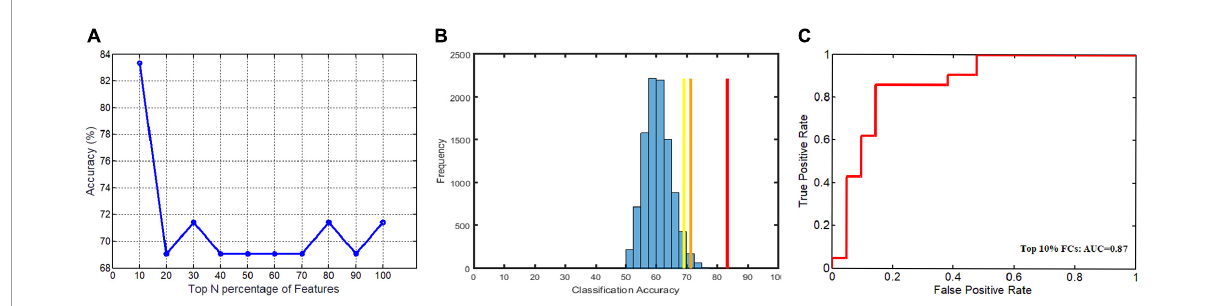
FIGURE1 The classification accuracies of 10 feature selection percentages, the corresponding null distribution, and the receiver operating characteristic (ROC) curve for the highest classification accuracies. (A) The highest classification accuracy (83.33%) was obtained when the top 10% FCs were selected and two lower accuracies (71.43% and 69.05%) were obtained when different numbers of FCs were selected; (B) the corresponding null distribution of the highest chance-level accuracies (the blue histogram), along with the three true classification accuracies (red: 83.33%; orange: 71.43%; yellow: 69.05%); (C) the receiver operating characteristic (ROC) curve and the area under the curve (AUC) (0.87) corresponding to this highest classification accuracy (83.33%).